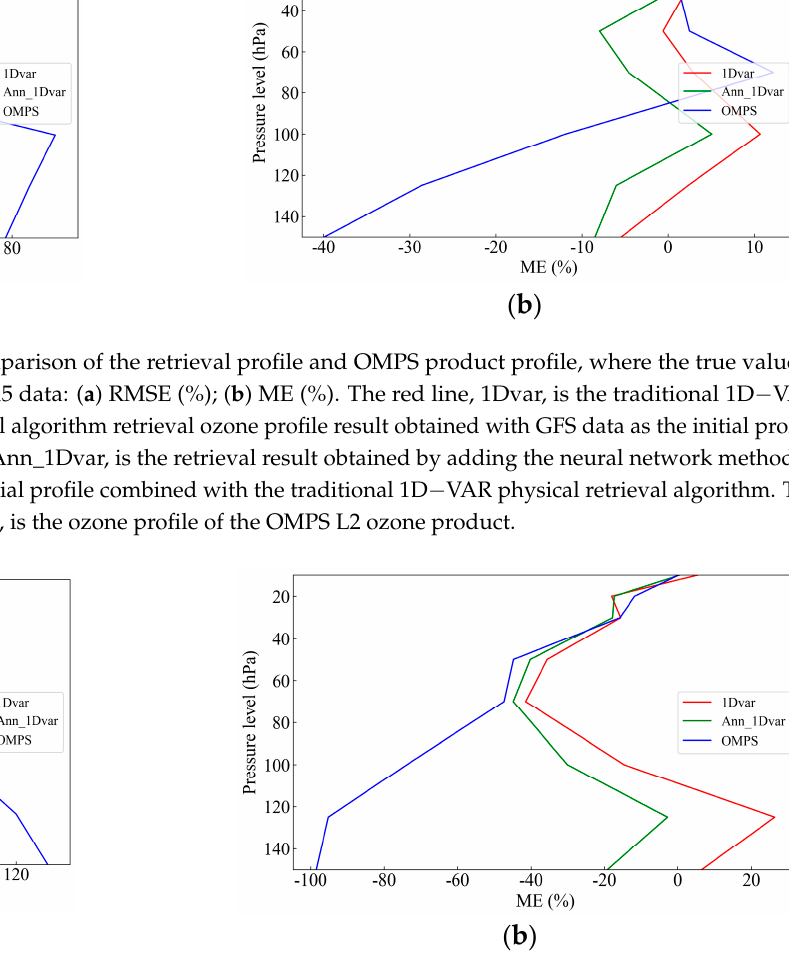
Figure 9. A comparison of the retrieval profile and OMPS product profile, where the true value is taken from the WOUDC ozone site data: ( a ) RMSE (%); ( b ) ME (%). The red line 1Dvar is the traditional 1D − VAR physical retrieval algorithm retrieval ozone profile result obtained with GFS data as the initial profile. The green line Ann_1Dvar is the retrieval result obtained by adding the neural network method to optimize the initial profile combined with the traditional 1D − VAR physical retrieval algorithm. The blue line OMPS is the ozone profile of OMPS L2 Ozone product.